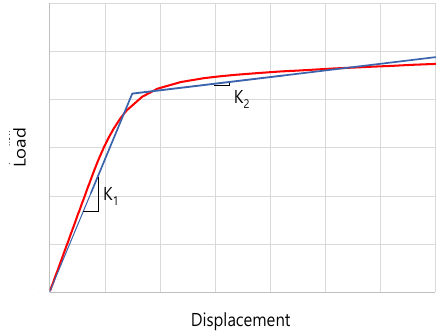
Figure 2. Force–displacement relationship.